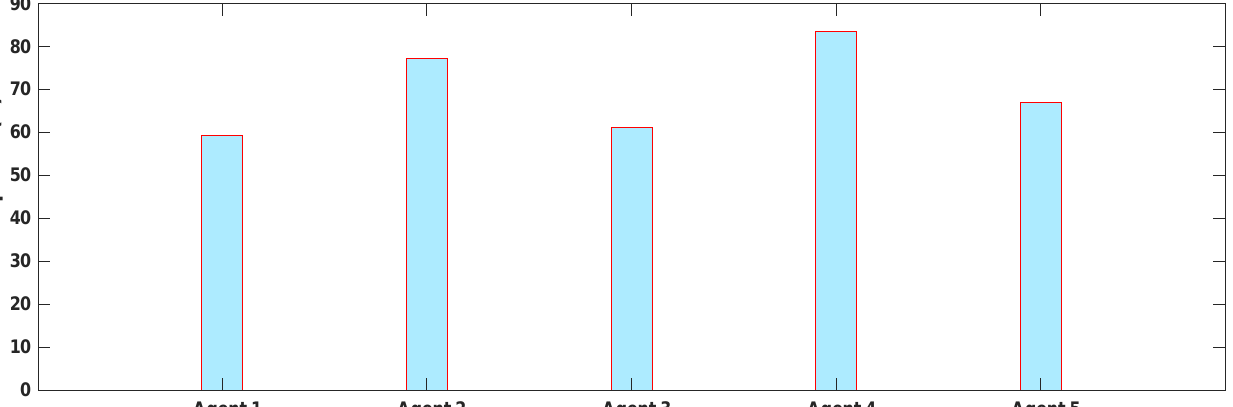
Figure 8. Example 1: Percent of control system updates.